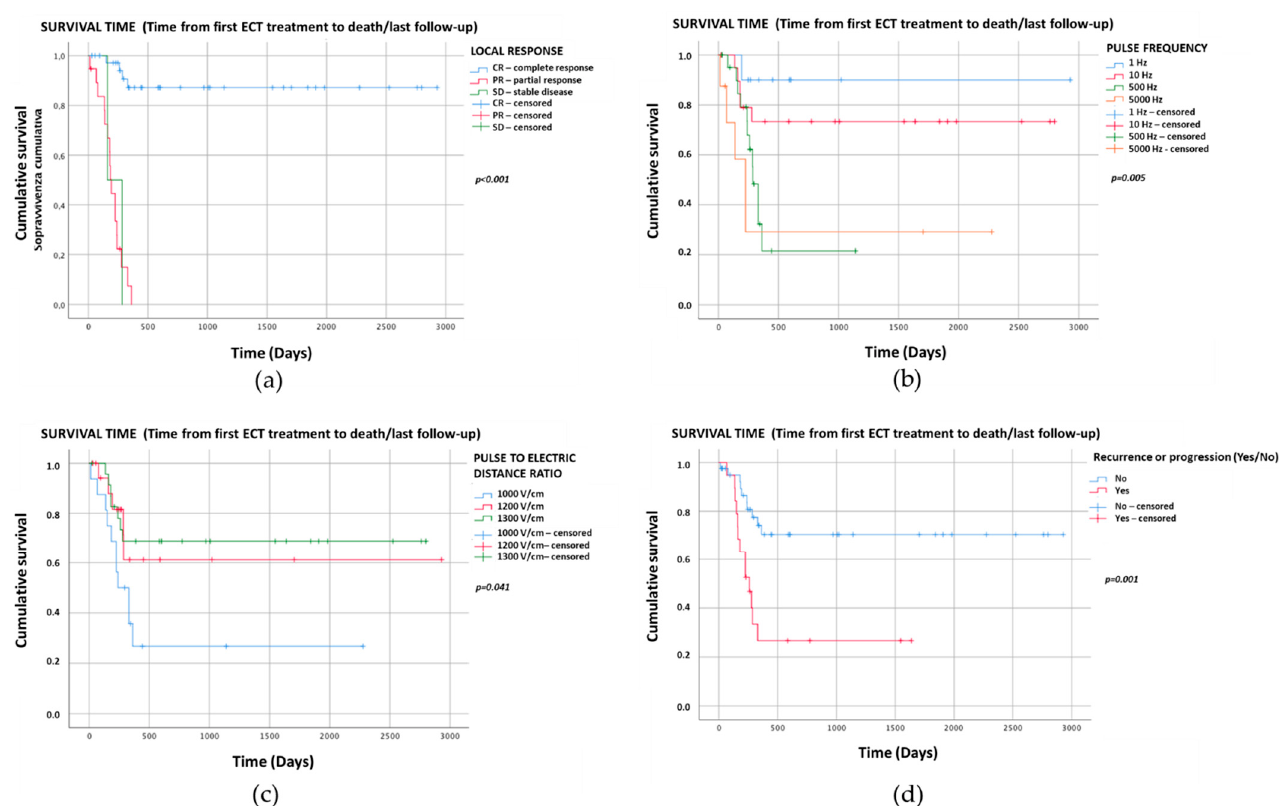
Figure 1. Kaplan–Meier graphs of the four categorical variables with p < 0.05 showing survival times (days). The comparison of survival curves with the log-rank test for ( a ) local treatment response was p < 0.001 (CR: median NR, 95%CI NR; PR: median 193, 95%CI 168–218; SD: median 160, 95%CI NR); ( b ) pulse frequency p = 0.005 (1 Hz: median NR, 95%CI NR; 10 Hz: median NR, 95%CI NR; 500 Hz: median 286, 95%CI 238–334; 5000 Hz: median 225, 95%CI 124–326); ( c ) amplitude to electrode distance ratio p = 0.041 (1000 V/cm: median 240, 95%CI 115-365; 1200 V/cm: median NR, 95%CI NR; 1300 V/cm: median NR, 95%CI NR); ( d ) recurrence/progression p = 0.001 (recurrence/progression: median 260, 95%CI 165-355; no recurrence/progression: median NR, 95%CI NR). NR—Not reached.